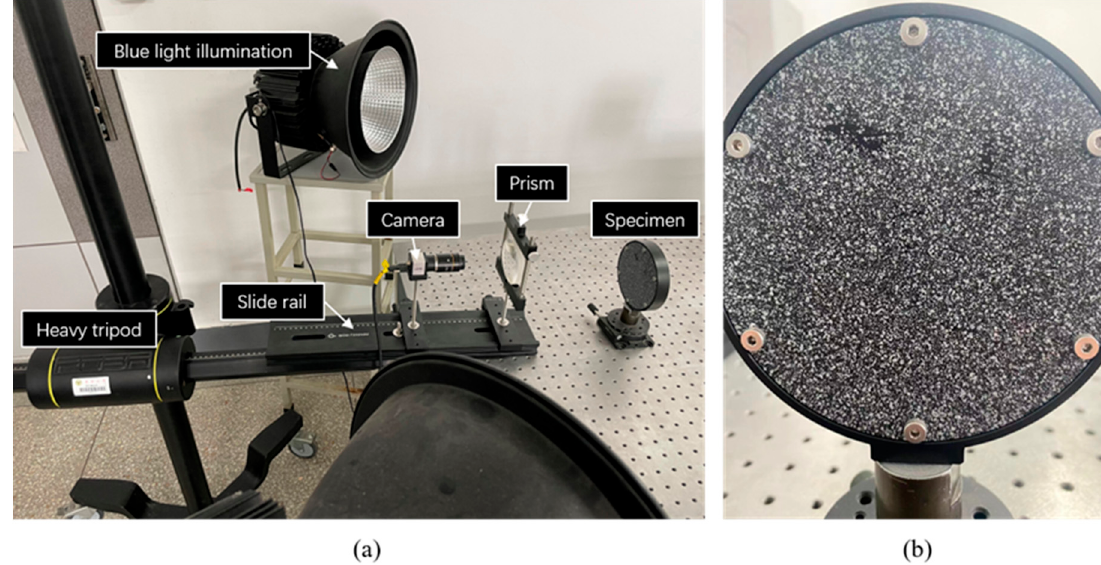
Figure 6. Static experiment for: ( a ) experiment setup; ( b ) specimen.